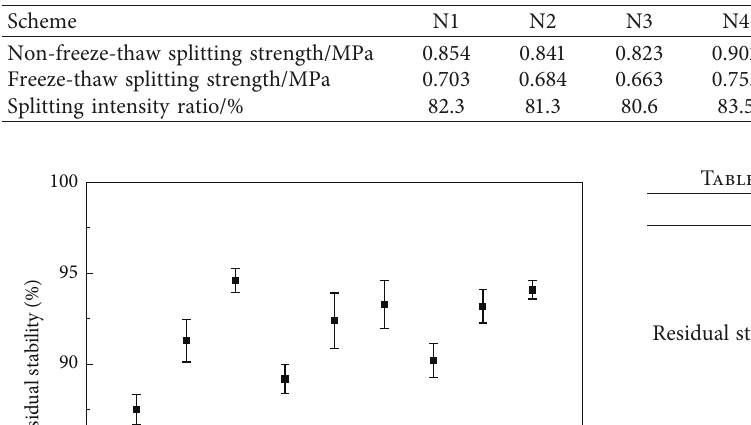
Table 12: Test results of freeze-thaw splitting.